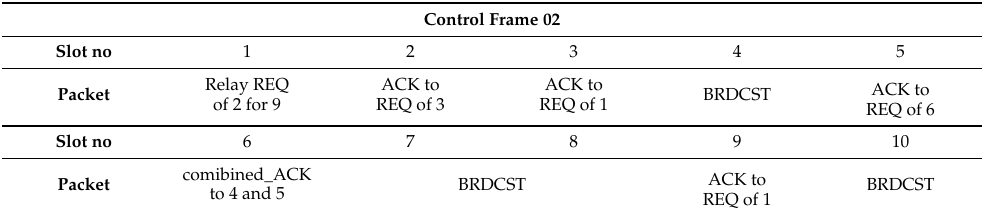
Table 7. Second control frame contains transmissions of all SDR.